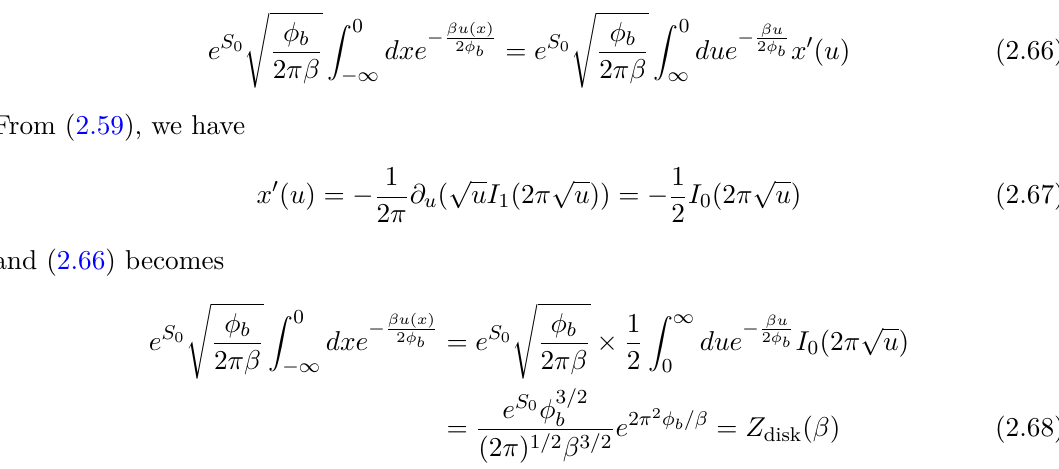
Figure 4. The plot of